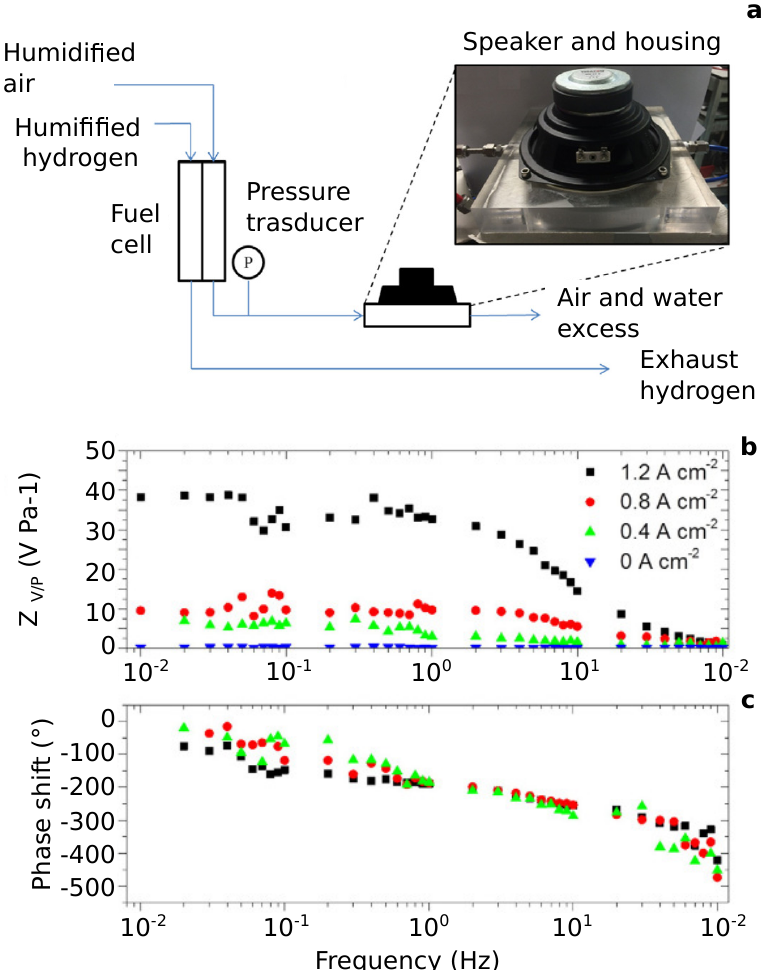
Figure 3. Electrochemical pressure impedance spectroscopy (EPIS) methodology: ( a ) EPIS setup developed by Engebretsen et al. [12], ( b ) EPIS magnitude Bode plots at different steady state, and ( c ) EPIS phase Bode plots at different steady states. Figures adapted from